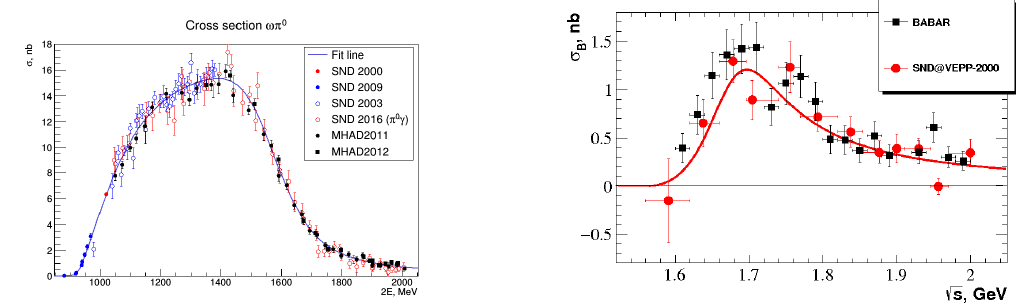
Figure 4. Left panel : The e + e − → ωπ 0 → π + π − π 0 π 0 cross section measured by SND at VEPP2000 and VEPP- 2M ([19, 20]) in comparison with e + e − → ωπ 0 → π 0 π 0 γ [13] cross section. Right panel : The e + e − → K + K − η cross section measured by SND at VEPP-2000 and in the BABAR experiment [24]. The solid curve is the result of the fit described in the